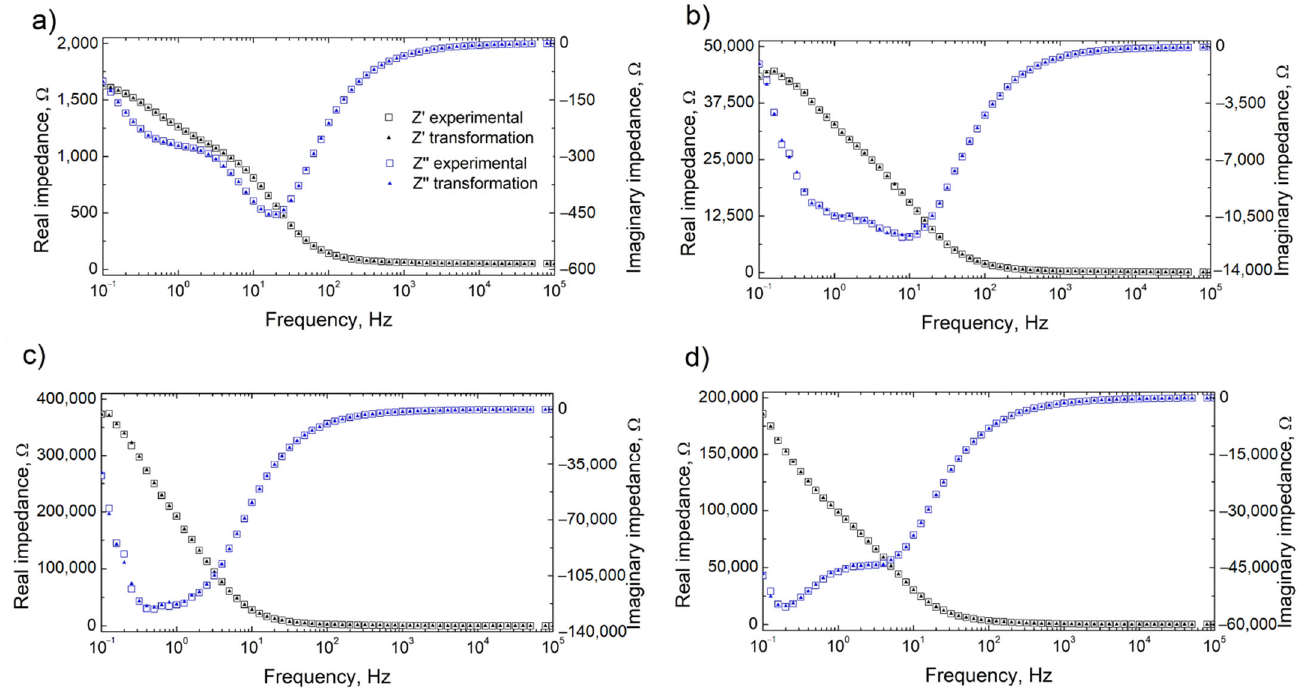
Figure 11. Comparison of experimental impedance data and transformed impedance data using K– K relationships: ( a ) uncoated AZ91D Mg alloy; ( b ) Base; ( c ) BF4; ( d ) F—PEO coatings.